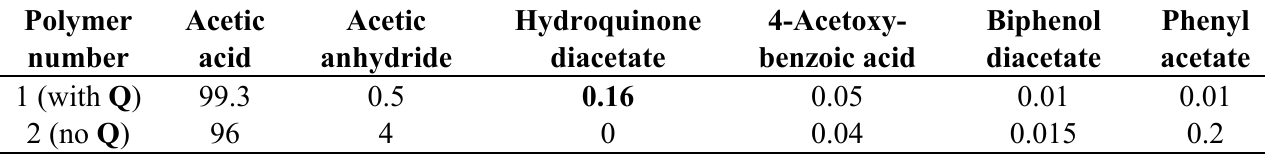
Table 2. Mole percentages of components of distillates from prepolymerizations of LCP’s by integration of the 1 H NMR spectra in CDCl